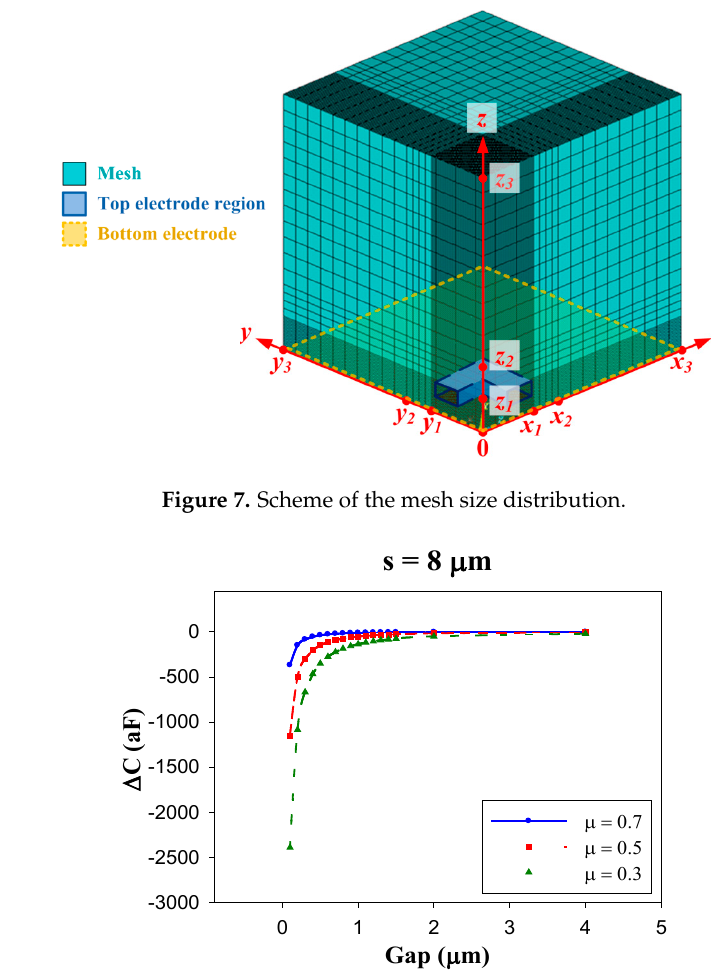
Figure 8. Simulation results of capacitance compensation term ( s = 8 μm). ∆ C : The capacitance